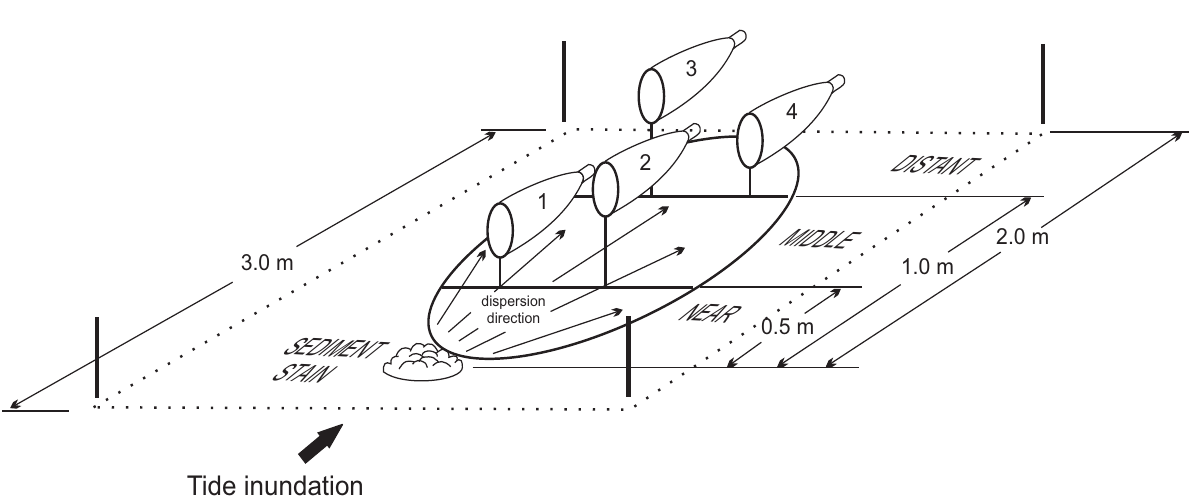
Figure 2. Schematic illustration of the dispersal experiment: (1) low-near net, (2) high-near net, (3) low-distant net, (4) high-distant